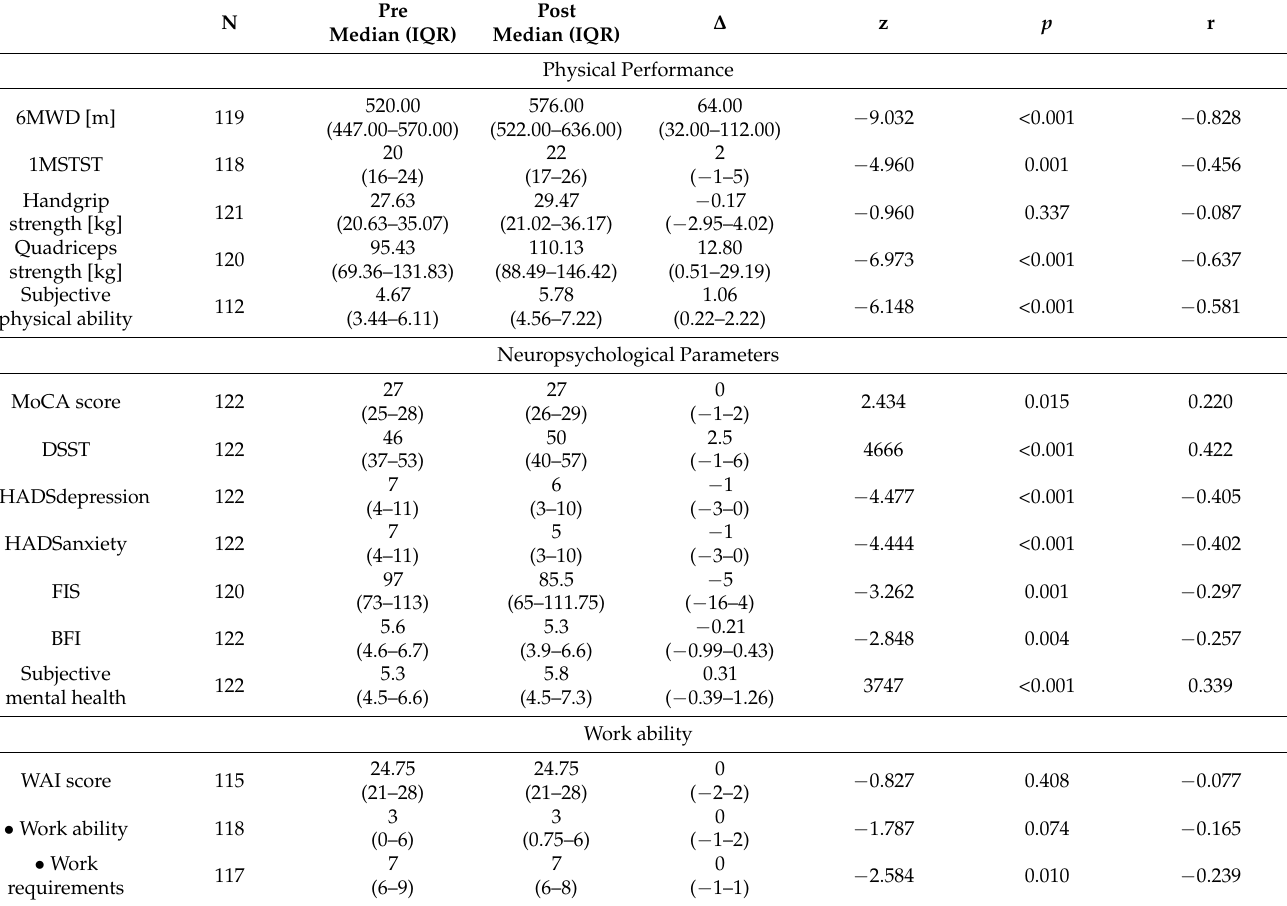
Table 3. Outcomes of an inpatient rehabilitation program in post-COVID